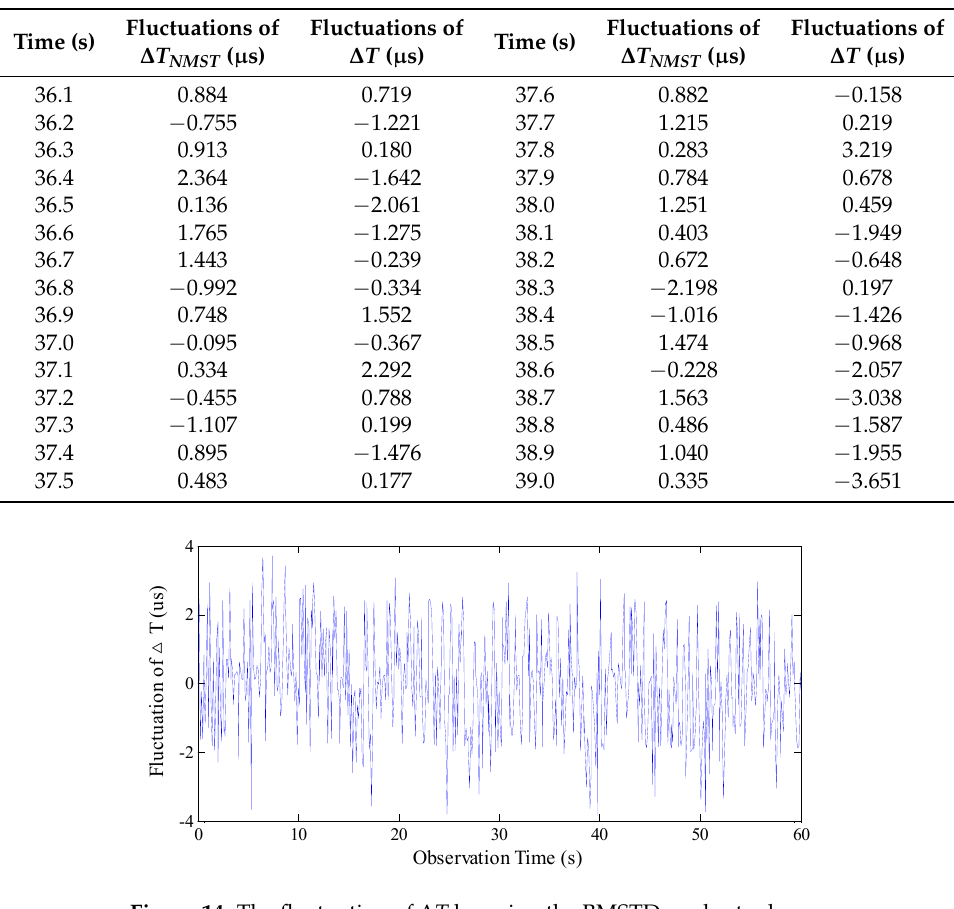
Figure 13. The fluctuation of Δ T NMST by using the NMST readout scheme. Table 1. Time difference fluctuations of 3 s by using two readout methods.